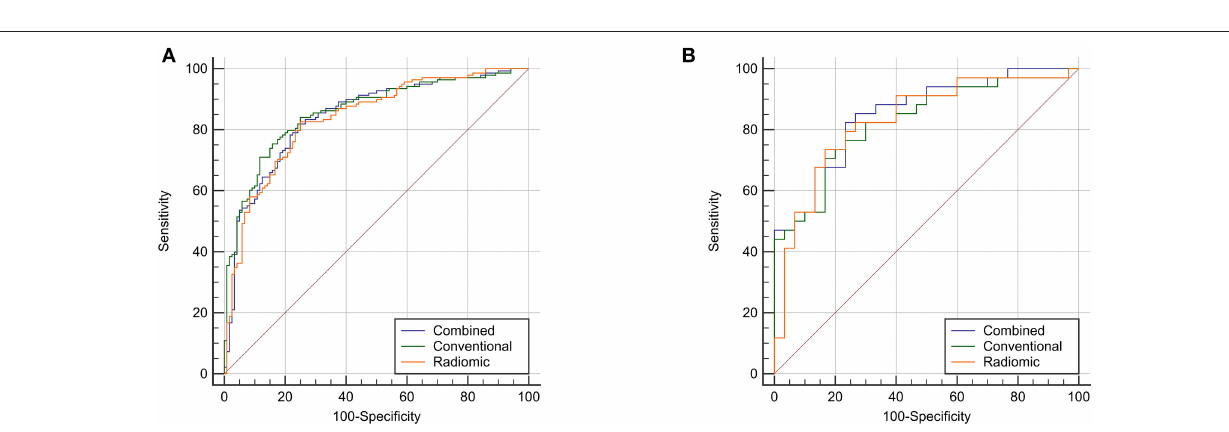
(conventional or radiomic features), predictive models built with machine learning algorithm could predict pGGN-like IVA from AIS/MIA well. The combination of conventional and